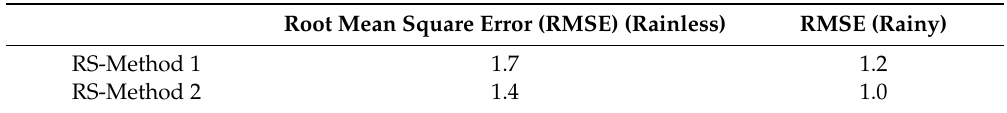
Table 2. Statistical results of tomography accuracy considering the radiosonde (RS) method as the reference under di ff erent weather conditions (g / m 3